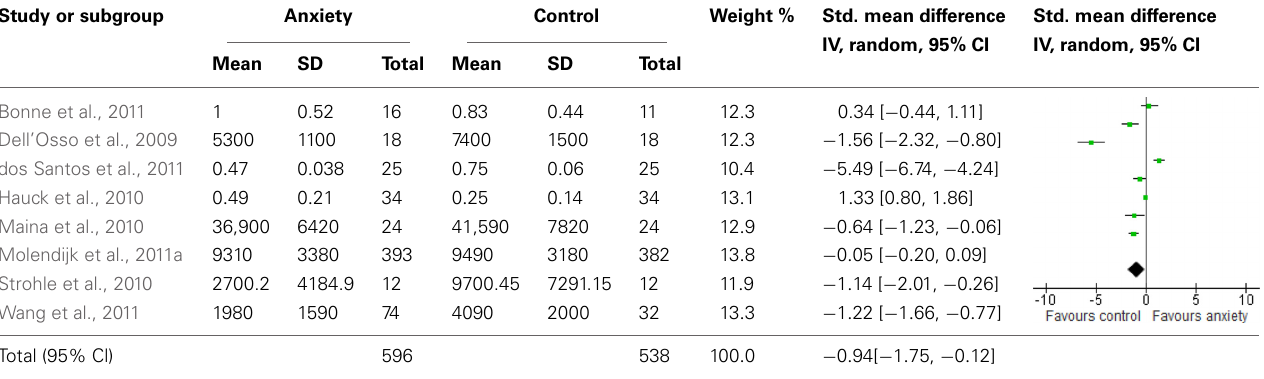
Table 3 | Meta-regression analysis of BDNF in anxiety disorders. Study or subgroup